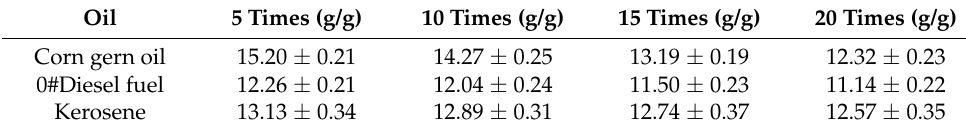
Table 2. Adsorption capacity of PDMS@Fe 3 O 4 /MS after multiple cycles.